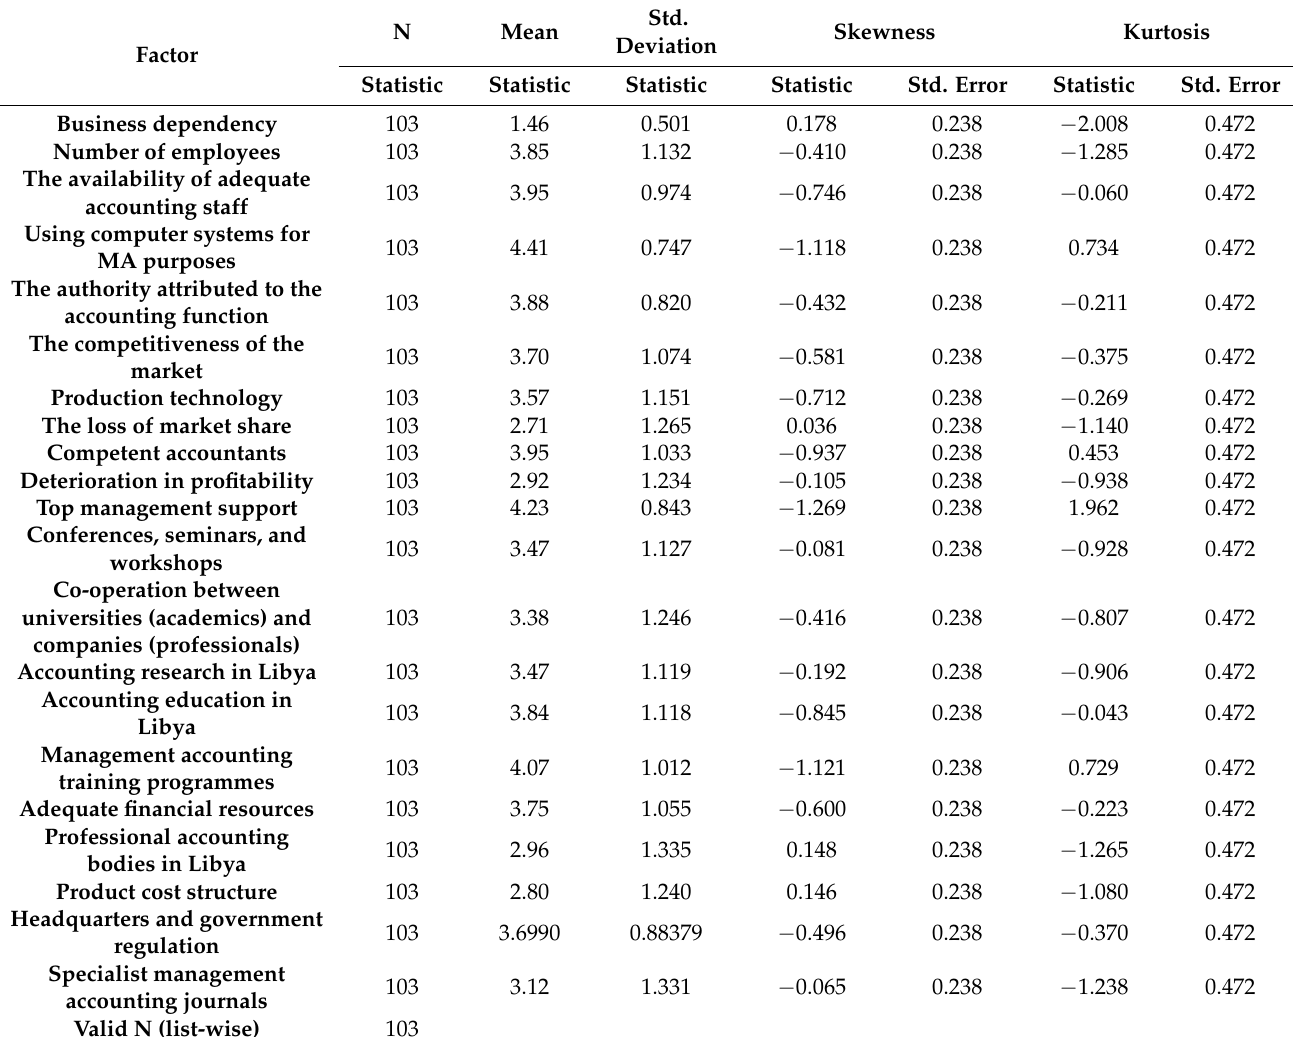
Table 4. Descriptive statistics for factors facilitating the adoption of